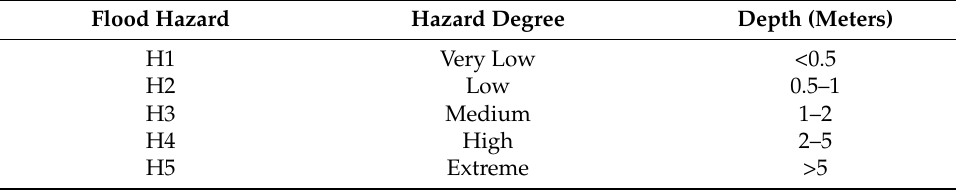
Table 2. Flood hazard classification according to MLIT